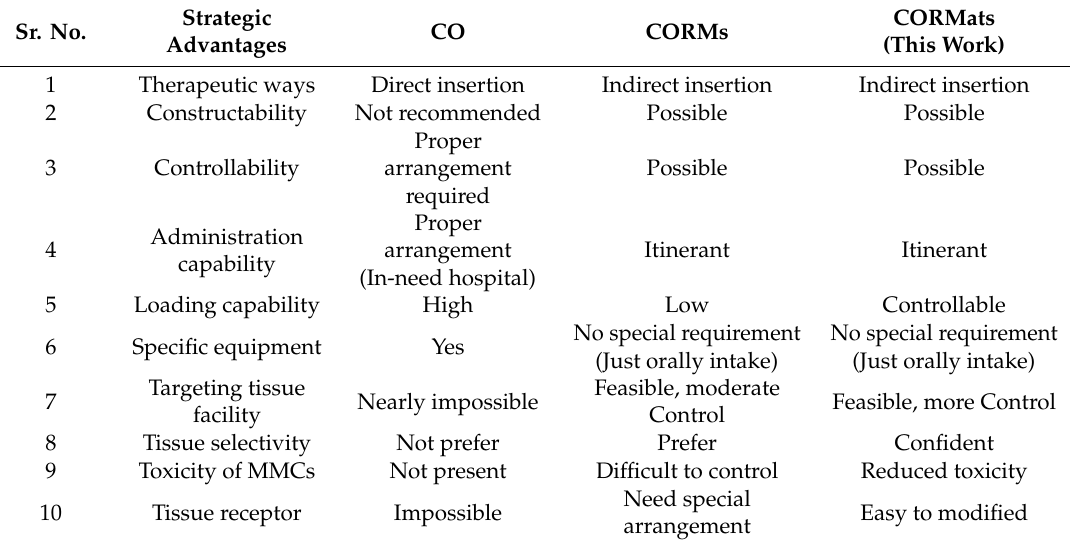
Table 1. The di ff erent administrations of CO for therapeutic